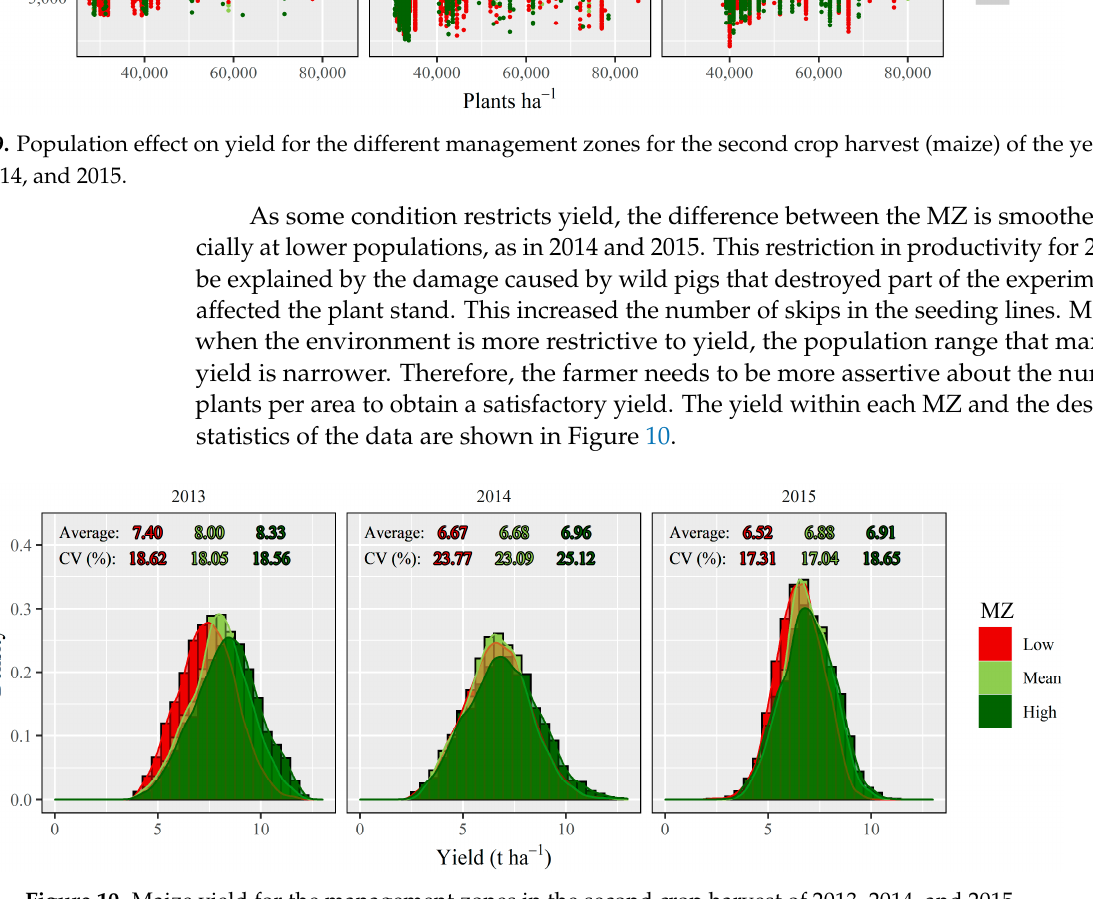
Figure 10. Maize yield for the management zones in the second crop harvest of 2013, 2014, and